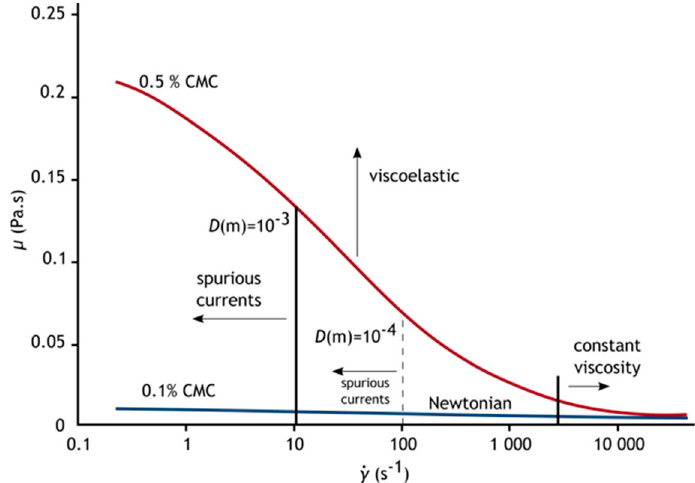
Figure 2. Viscosity of CMC solutions as a function of the shear rate, showing the main constrains to the study. Viscosity curves were calculated using Equation (20).